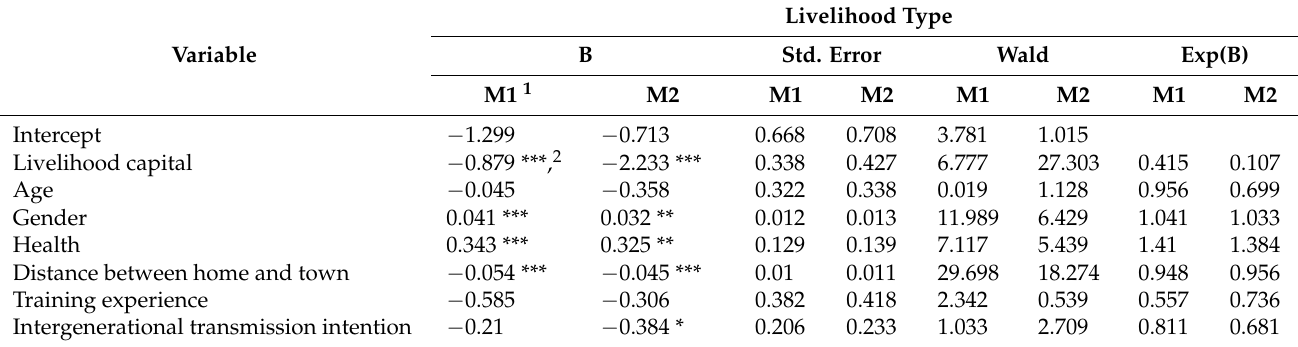
Table 7. Results of the moderating effect of sense of responsibility